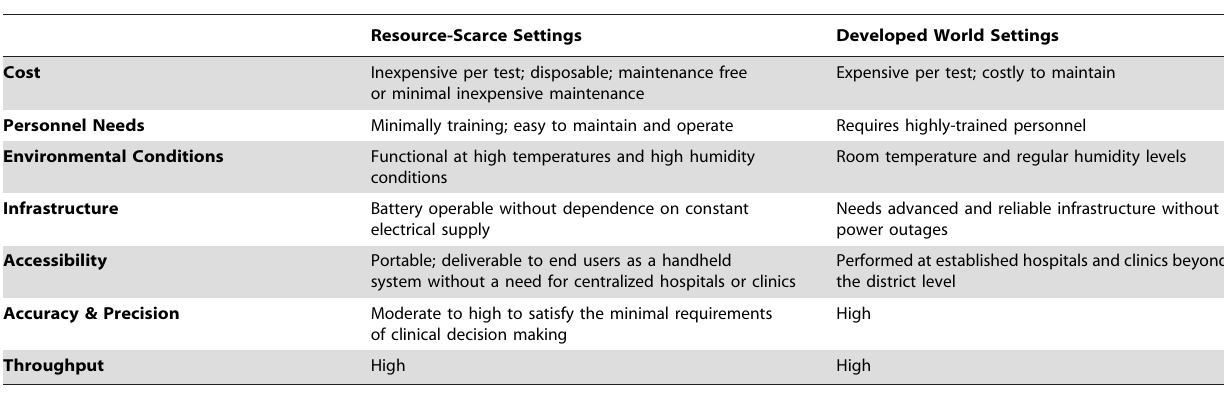
Table 1. Comparison for the design requirements and operational demands of a POC monitoring device based on World Health Organization (WHO) Standards for POC healthcare delivery at resource-scarce settings, and conventional devices at developed world